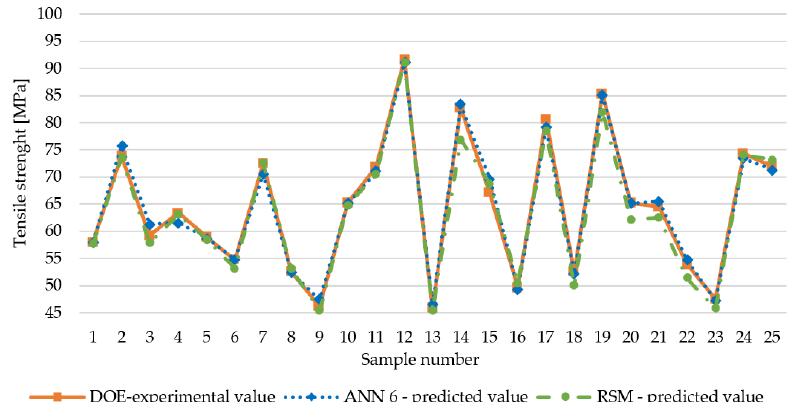
Figure 13. Experimental tensile strength vs. predicted tensile strength of the training data.